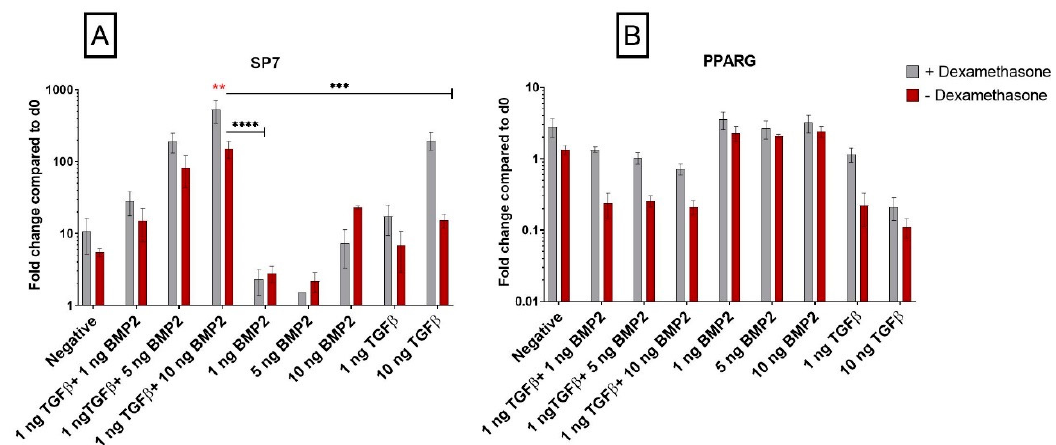
Figure 3. Dexamethasone modulates SP7 (Osterix) and PPARG genes expression in hSDSCs exposed to TGF- β 1 and BMP-2. Cells were cultured for 21 days in the presence of 10 ng/mL TGF- β 1 (positive control) or in its absence (negative), low TGF- β 1 concentration (1 ng/mL TGF- β 1), various concentrations of BMP-2 alone (1 ng/mL BMP-2, 5 ng/mL BMP-2, 10 ng/mL BMP-2) or BMP-2 in combination with TGF- β 1 (1 ng/mL TGF- β 1 + 1 ng/mL BMP-2, 1 ng/mL TGF- β 1 + 5 ng/mL BMP-2 and 1 ng/mL TGF- β 1 + 10 ng/mL BMP-2). The amounts of SP7 ( A ) and PPARG ( B ) mRNA were normalized to RPLP0 . The levels of gene expression of cells exposed to different media in the presence or absence of 100 nM dexamethasone were plotted as a fold change relative to the expression of the corresponding gene in undifferentiated cells (hSDSC day 0) defined as 1 (mean ± SD; n = 4). Grey bars represent scatterplot of different measurement in hSDSC exposed to dexamethasone, red bars represent scatterplot of different measurement in hSDSC not exposed to dexamethasone. Data are expressed as mean ± SD; significant difference from dexamethasone treatment in the same group is marked by red asterisks; significant difference among groups is marked by black asterisks (* p ≤ 0.05, ** p ≤ 0.01, *** p ≤ 0.001, **** p ≤